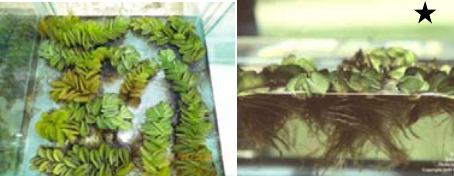
Fig. 1. Design of phytotoxicity test at different diesel concentrations.